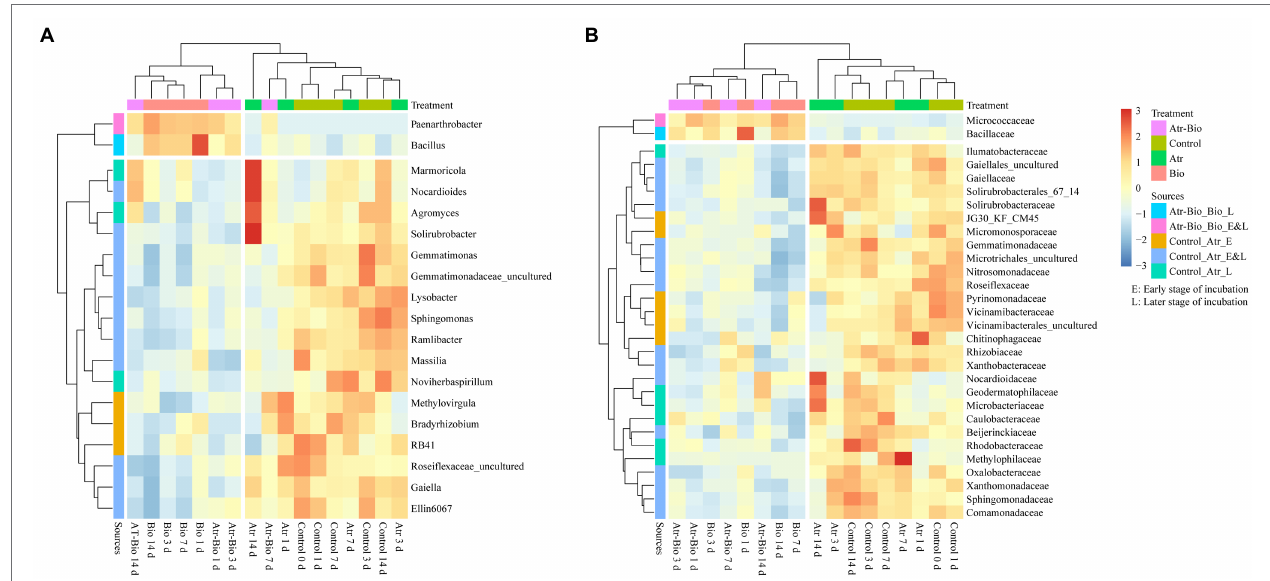
FIGURE 5 | Heatmaps showing relative abundances of differentially abundant genera (A) and families (B) identified by LEfSe analysis. Control: equivalent amount of methanol and ddH 2 O were added into native soil; Atr: native soil spiked with atrazine; Atr-Bio: atrazine-spiked soil with inoculation of strain AT-5; Bio: native soil with inoculation of strain AT-5. Atr-Bio_Bio, comparison of Atr-Bio treatment vs. Bio treatment, Control_Atr, comparison of Control treatment vs. Atr treatment. Early stage, 0–5 days; late stage, 7–14